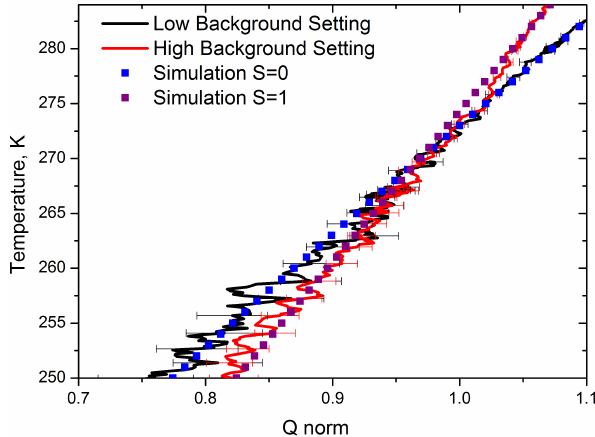
Figure 7. Measured ratio Q of the rotational Raman signals with the high- and low-background setting, H and L , respectively, at night. The data for the setting H were collected between 19:38 and 19:58UTC on 18 May 2013, and data for the setting L just after- wards between 20:05 and 20:25UTC. The intensity of the RR2 sig- nal decreased by switching to L, hence the smaller ratio Q . The rotational signals were smoothed with a gliding average of 105m height before the ratio was calculated.